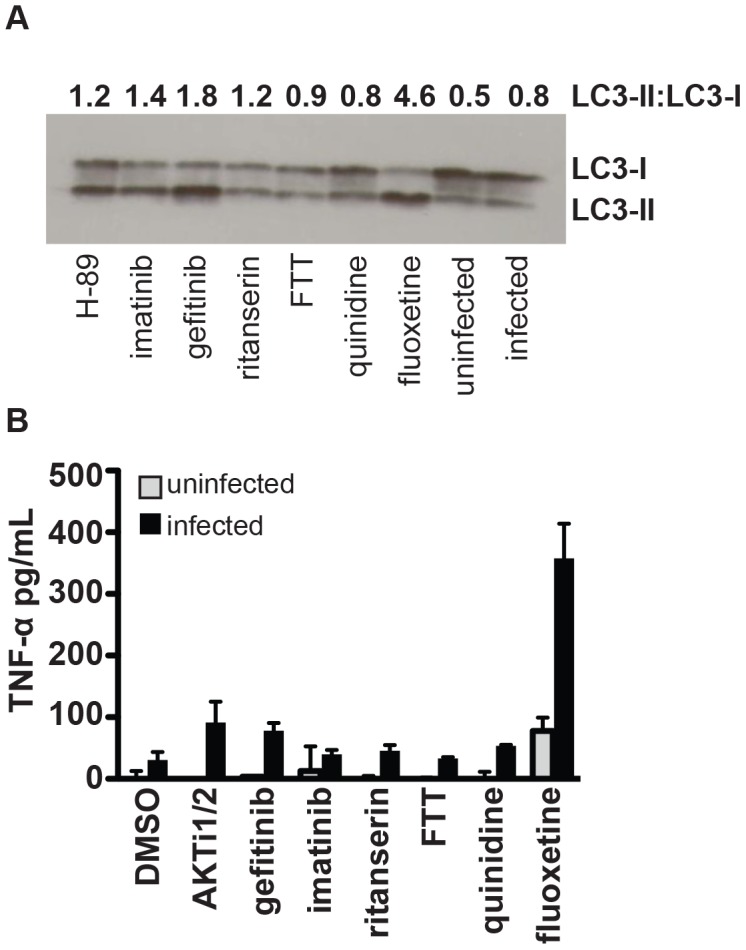
Specific compounds enhance autophagy or inflammatory cytokine release.(A) J774 murine macrophages were infected with H37Rv, then treated with the indicated compounds. Cells were harvested for Western-blot analysis of LC3 conversion from LC3-I to LC3-II as an indicator of autophagy. Data represents one of three independent experiments. Densitometry for LC3-II to LC3-I ratio for the shown Western blot was performed using ImageJ image analysis software. (B) Cells were infected with H37Rv, then treated with compound after a 4 hour phagocytosis. Supernatants were collected at 24 hours after infection and TNF-α concentration was determined by ELISA. Points represent average for 2 wells +/− standard deviation. Data represents one of two independent experiments.